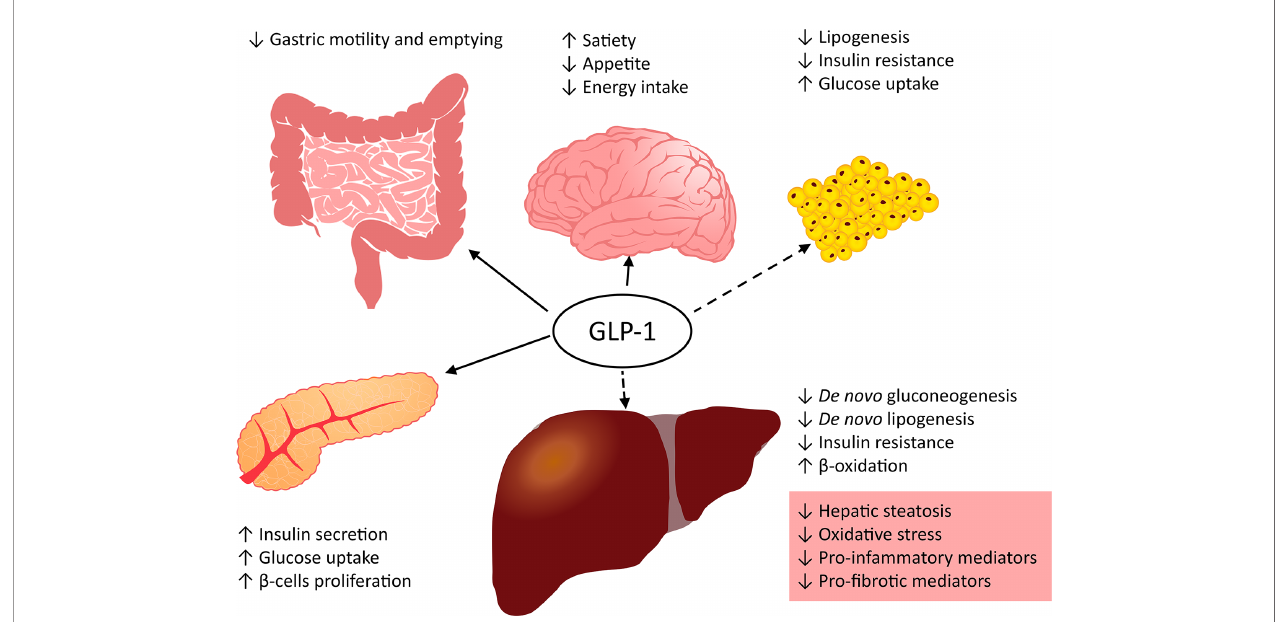
FIGURE 3 | Role of GLP-1 in